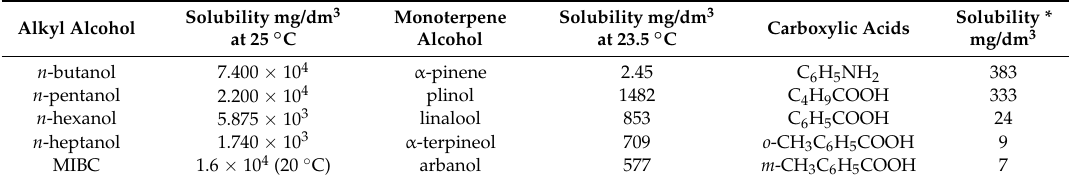
Table 6. Solubility in water of selected organic frothers (based on [26–29]).